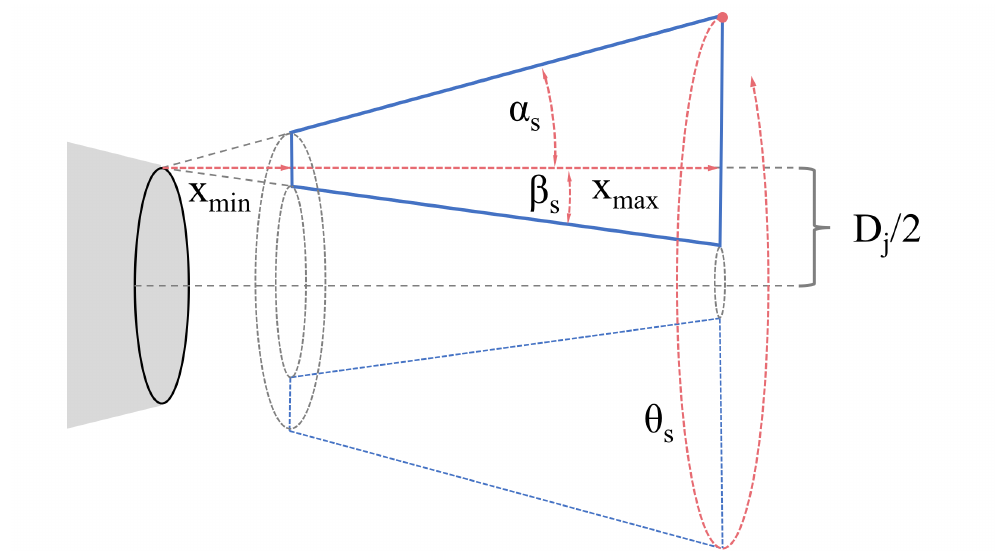
Figure 3. Source Region for Synthetic